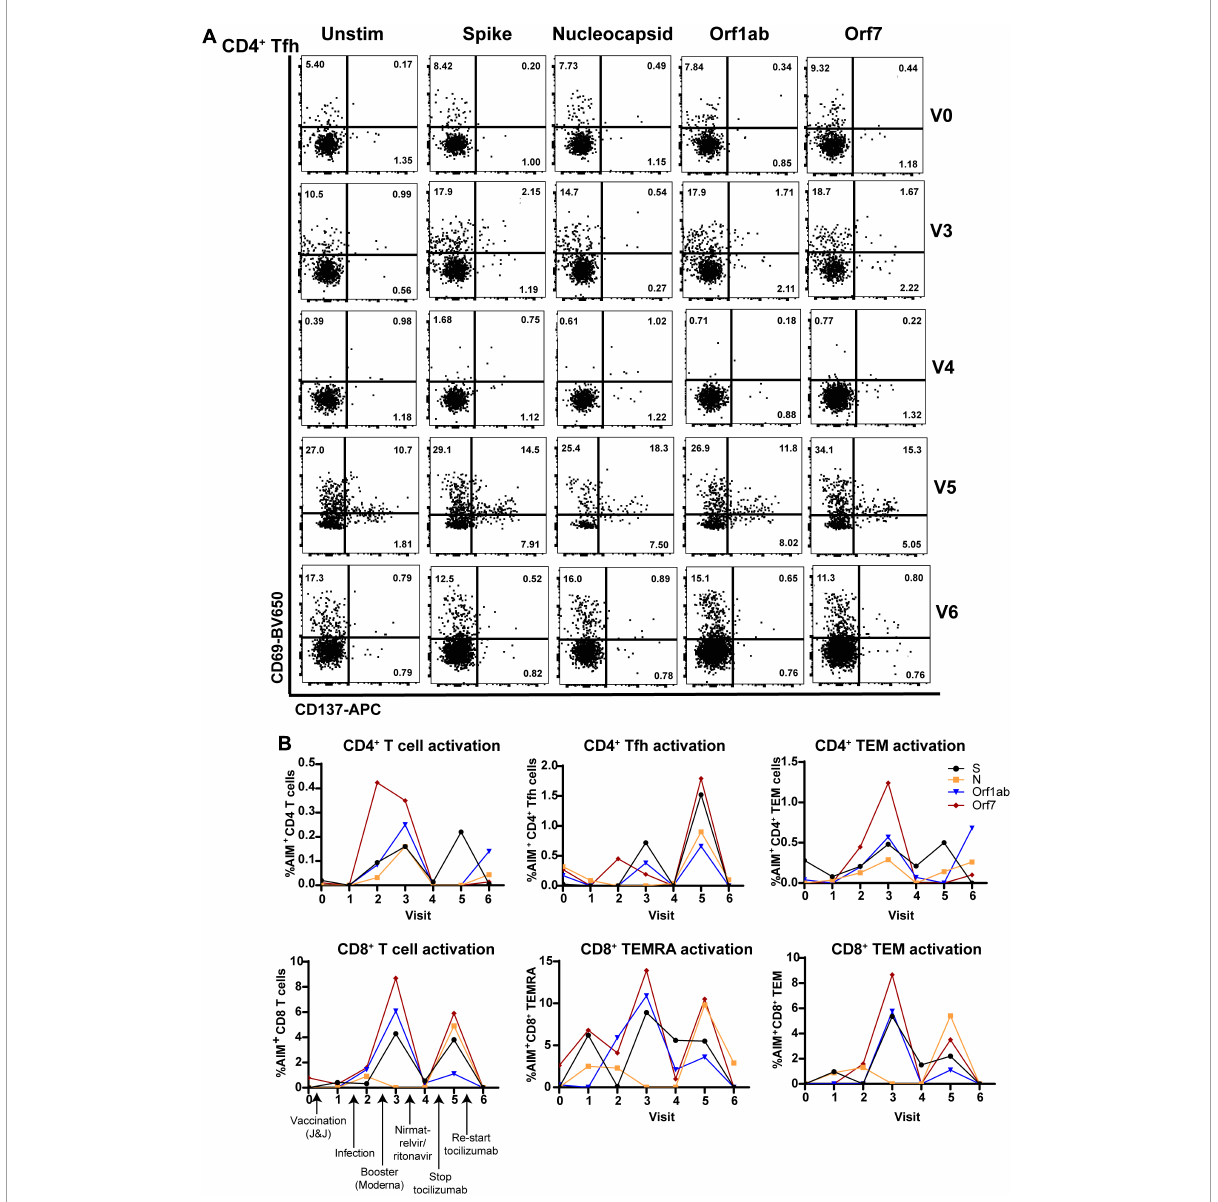
FIGURE3 Virus-specific CD4 + and CD8 + T cell subset activation correlates with antiviral and tocilizumab treatment. (A) Flow cytometry showing elevated virus-specific CD4 + T helper cell (Tfh) cell activation after vaccine booster dose (V3; 2nd row) and stopping tocilizumab treatment (V5; 4th row). (B) Total CD4 + T cells (left), CD4 + T helper cells (Tfh, middle), and CD4 + memory T cells (TEM, right) have enhanced reactivity to SARS-CoV-2 structural (S, N) and non-structural (Orf1ab, Orf7) peptides after vaccine booster (V3) and stopping tocilizumab (V5), but